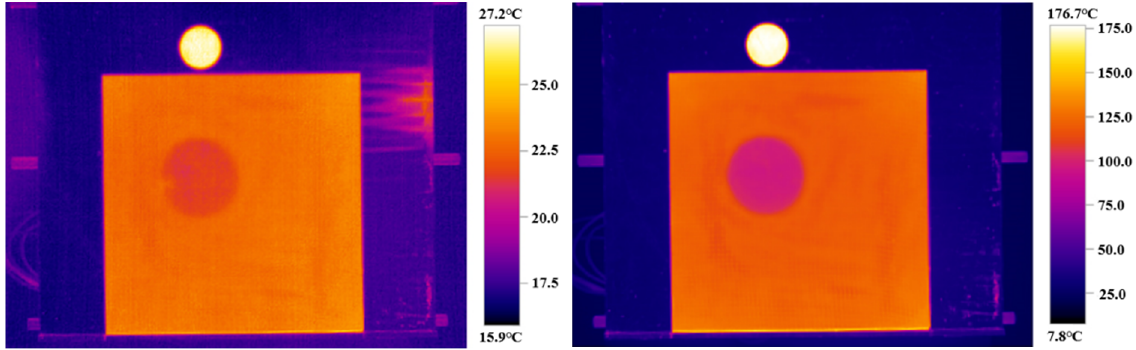
Figure 7. Infrared chart at 30 °C and 200 °C.